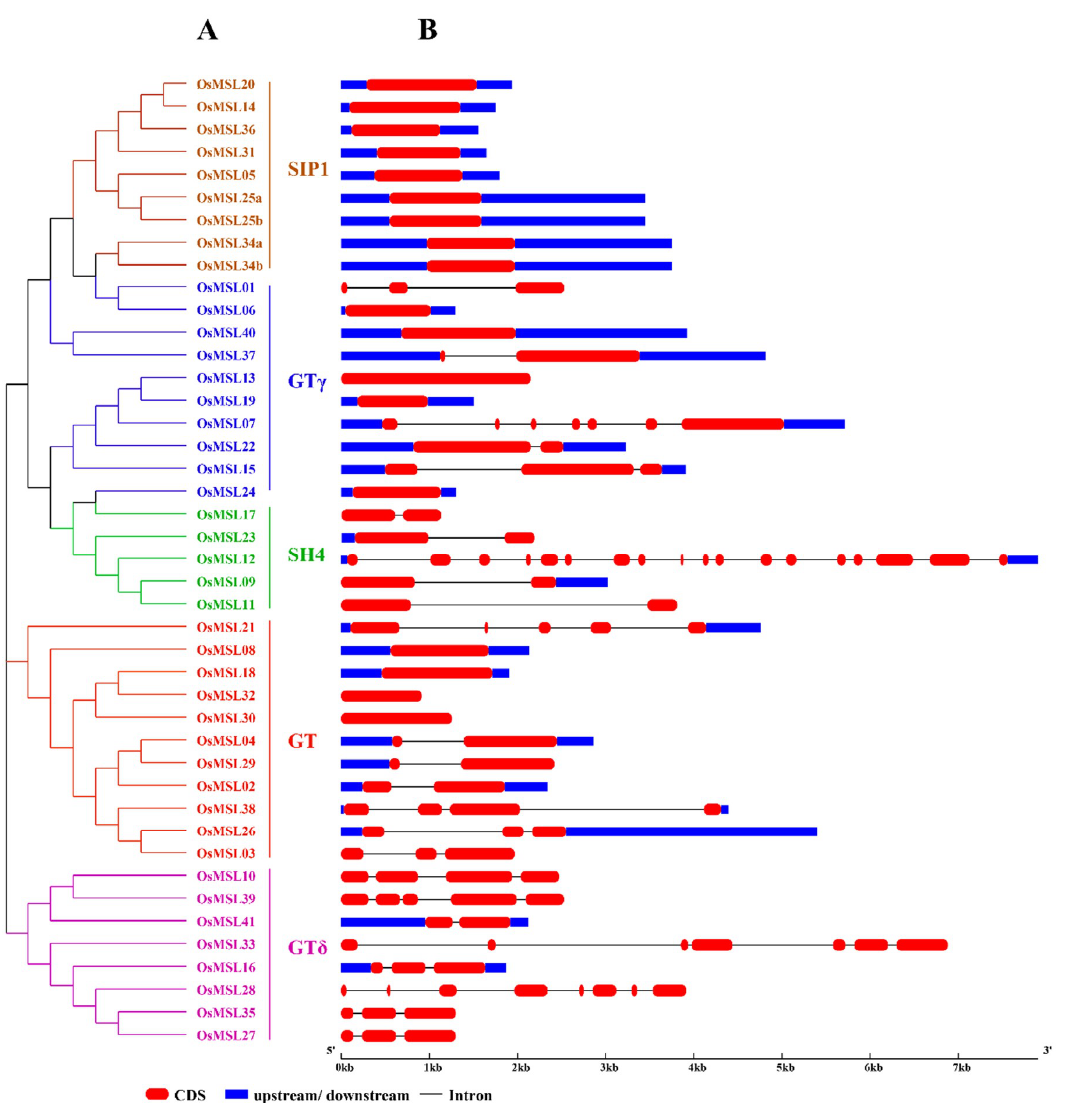
Figure 5. Phylogenetic analysis and gene structure of the rice trihelix family. ( A ) Phylogenetic analysis of the rice trihelix family. The phylogenetic tree was constructed based on the full-length amino acid sequences of the rice trihelix proteins by using MEGA v. 7.0 with the maximum-likelihood method. Bootstrap = 1,000. SIP1, GTγ, GT, SH4, and GTδ are marked with different colors. ( B ) Gene structures of the rice trihelix family. These were analyzed by the Gene Structure Display Server (GSDS v. 2.0). Exons, introns, and untranslated regions are marked by round red rectangles, black lines, and blue rectangles, respectively. The scale bar at the bottom estimates the lengths of the exons, introns, and untranslated regions.